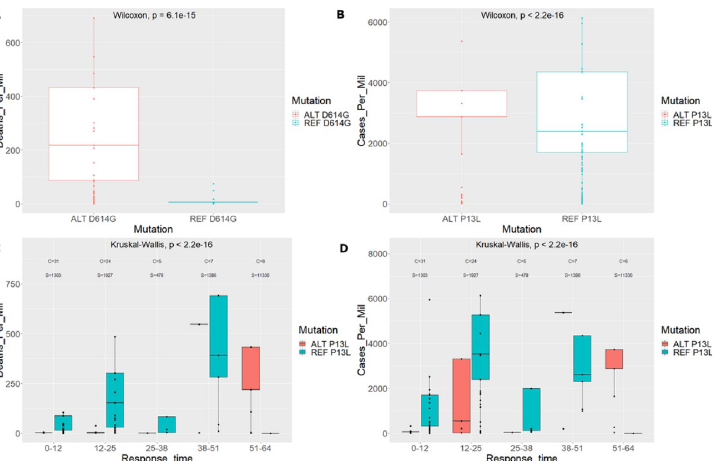
Fig 5. Boxplot distributions with and without the P13L mutation. A. Deaths per million for countries with the P13L mutation and the reference mutation. B. Cases per million for countries with the P13L mutation and the reference mutation. Keep in mind that each data point can represent more than one country. C. Deaths per million for countries with the P13L mutation and the reference mutation including response time separation. C denotes the number of unique countries in the group and S is the number of strains in the group. D. Cases per million for countries with the P13L mutation and the reference mutation including response time separation. C and S are as denoted for panel C.